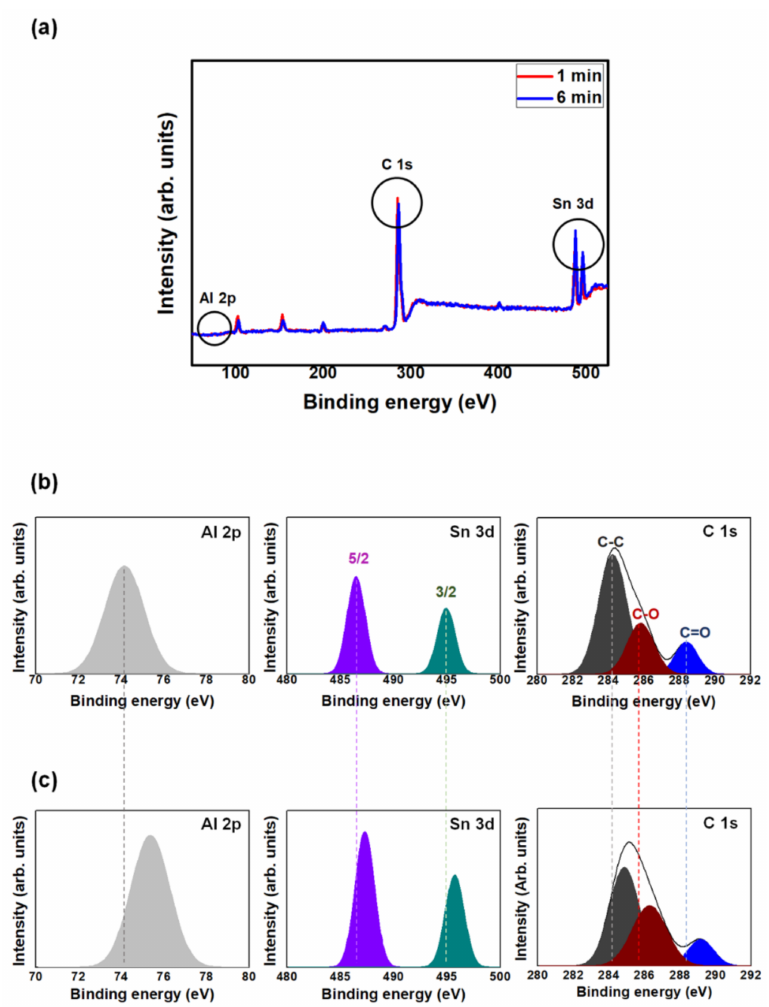
Figure 4. ( a ) XPS survey-scan spectra in the range of 50 to 525 eV for the 1 min and 6 min UV-exposed hybrid films. High resolution Al 2p, Sn 3d, and C 1s core-level XPS data for the ( b ) 1 min and ( c ) 6 min UV-exposed hybrid